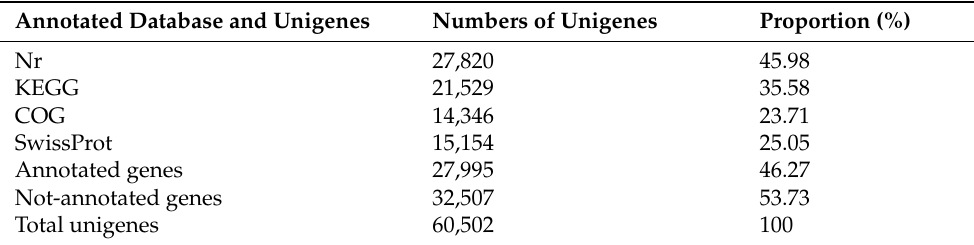
Table 2. Summary of O. asiaticus data annotation from four databases.